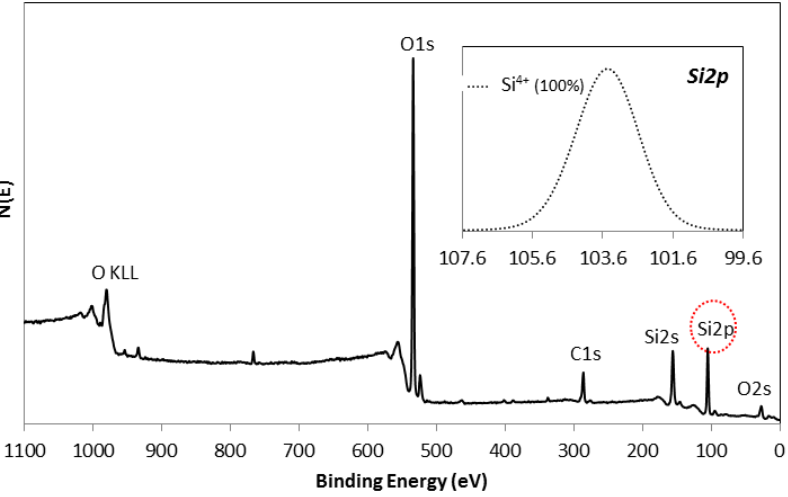
Figure 4. XPS survey spectrum of SiO 2 coating sintered at 500 °C in the blower and in the inset the XPS spectra corresponding to the Si 2p.